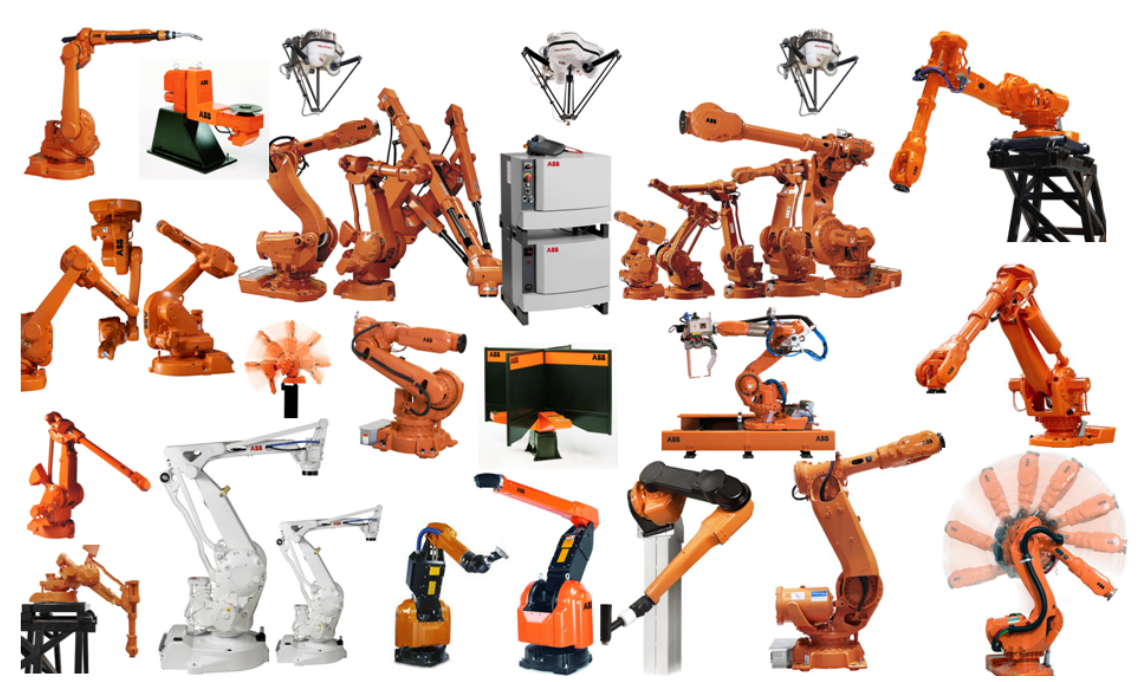
Figure 4: The dynamic- and kinematics models needed for model-based control must be developed and maintained for the whole robot family of